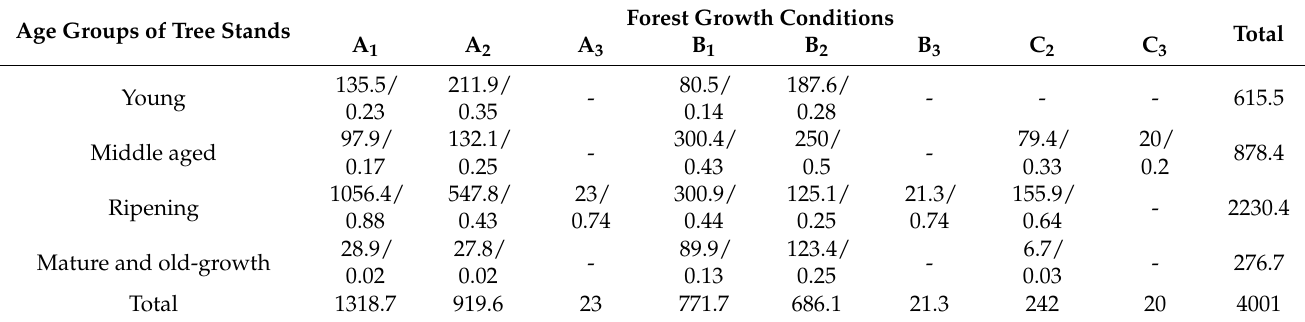
Table 4. Distribution by age groups of forest areas covered by fires depending on forest growth conditions (ha)/burning index